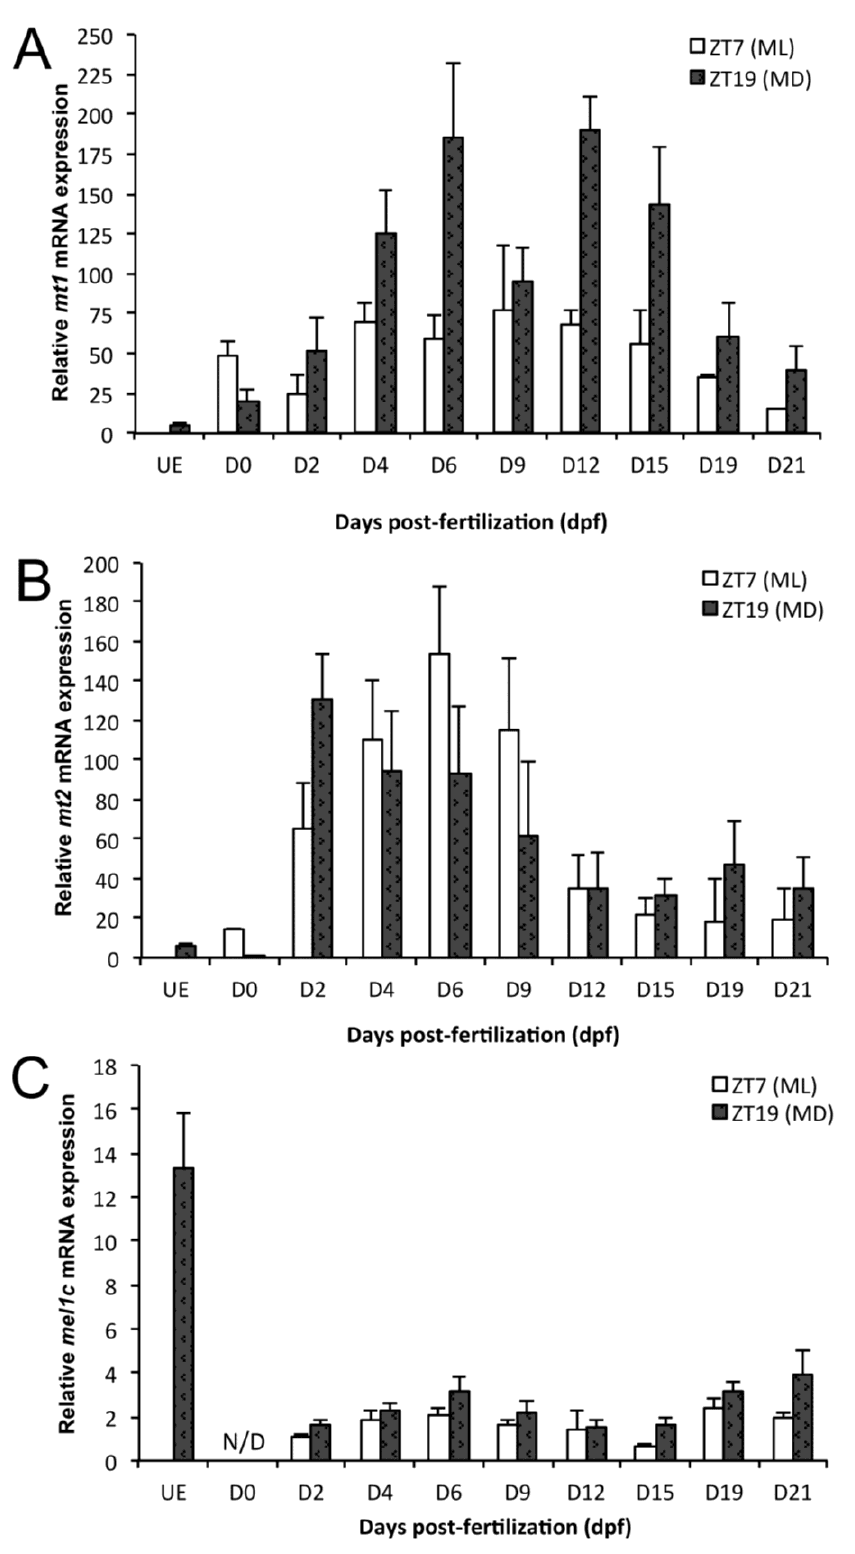
Figure 1. Relative expression of mt1 ( A ); mt2 ( B ); and mel1c ( C ) in unfertilized eggs (UE), embryos, and larvae at different stages of development in Senegalese sole specimens sampled at ZT7 (midday or ML) and ZT19 (midnight or MD). mRNA levels were measured by real-time PCR on pools of animals. Data are shown as the mean ± SEM ( n = 3–4). For statistical analysis, see Material and Methods and Table